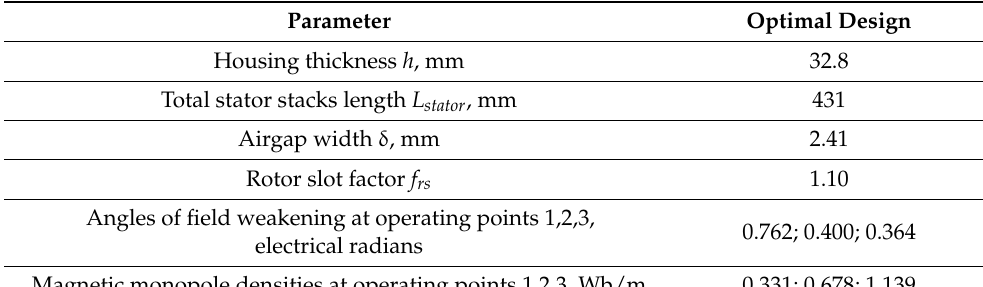
( d ) Figure 5. Variations in the objectives during the optimization: ( a ) total losses < P losses >; ( b ) maximum current amplitude in the armature winding; ( c ) maximum voltage amplitude in the armature wind- ing; ( d ) objective function F .